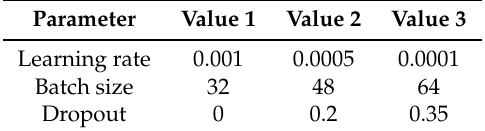
Table 3. Grid search values for exhaustive parameters optimization.